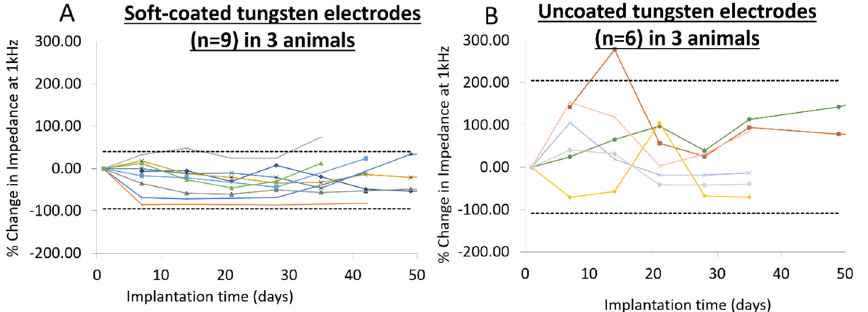
Figure 7. Comparison of change in absolute impedance at 1 kHz for ( A ) coated and ( B ) uncoated tungsten electrode over 5–7 weeks. Dotted lines indicate 95% confidence intervals assessed over all data points across implantation times within the group (coated vs. uncoated). Tungsten electrodes coated with soft siloxane were relatively more stable over implantation time compared to uncoated controls.